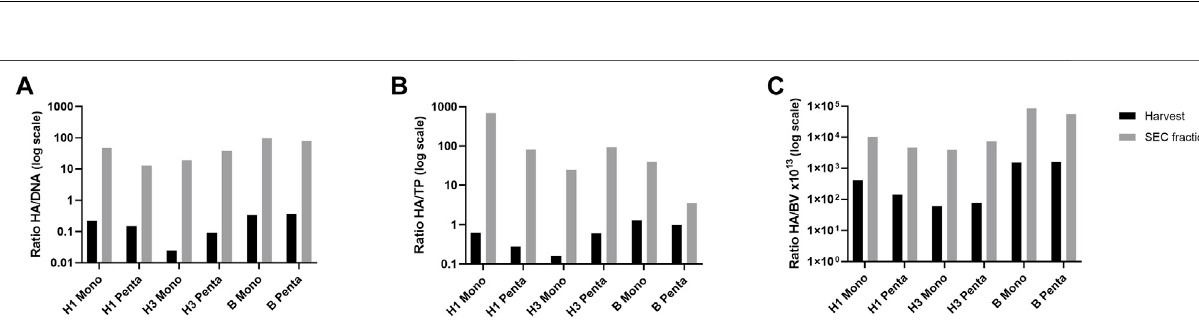
FIGURE 2 | Identi fi cation of HA and M1 proteins by Western blot in VLP samples after harvest and after downstream processing (SEC fraction selected). (A) H1 MonoVLP, (B) H1PentaVLP, (C) H3MonoVLP, (D) H3PentaVLP, (E) BMonoVLP, (F) BPentaVLP.MW:molecularweightproteinmarkers;TP:totalprotein;initialTP: harvest sample loaded by total protein amount; fi nal TP: SEC fraction selected sample loaded by total protein amount; initial HA: harvest sample loaded by HA protein amount; fi nal HA: SEC fraction selected sample loaded by HA protein amount. HA MW = 63 kDa, M1 MW = 28 kDa.